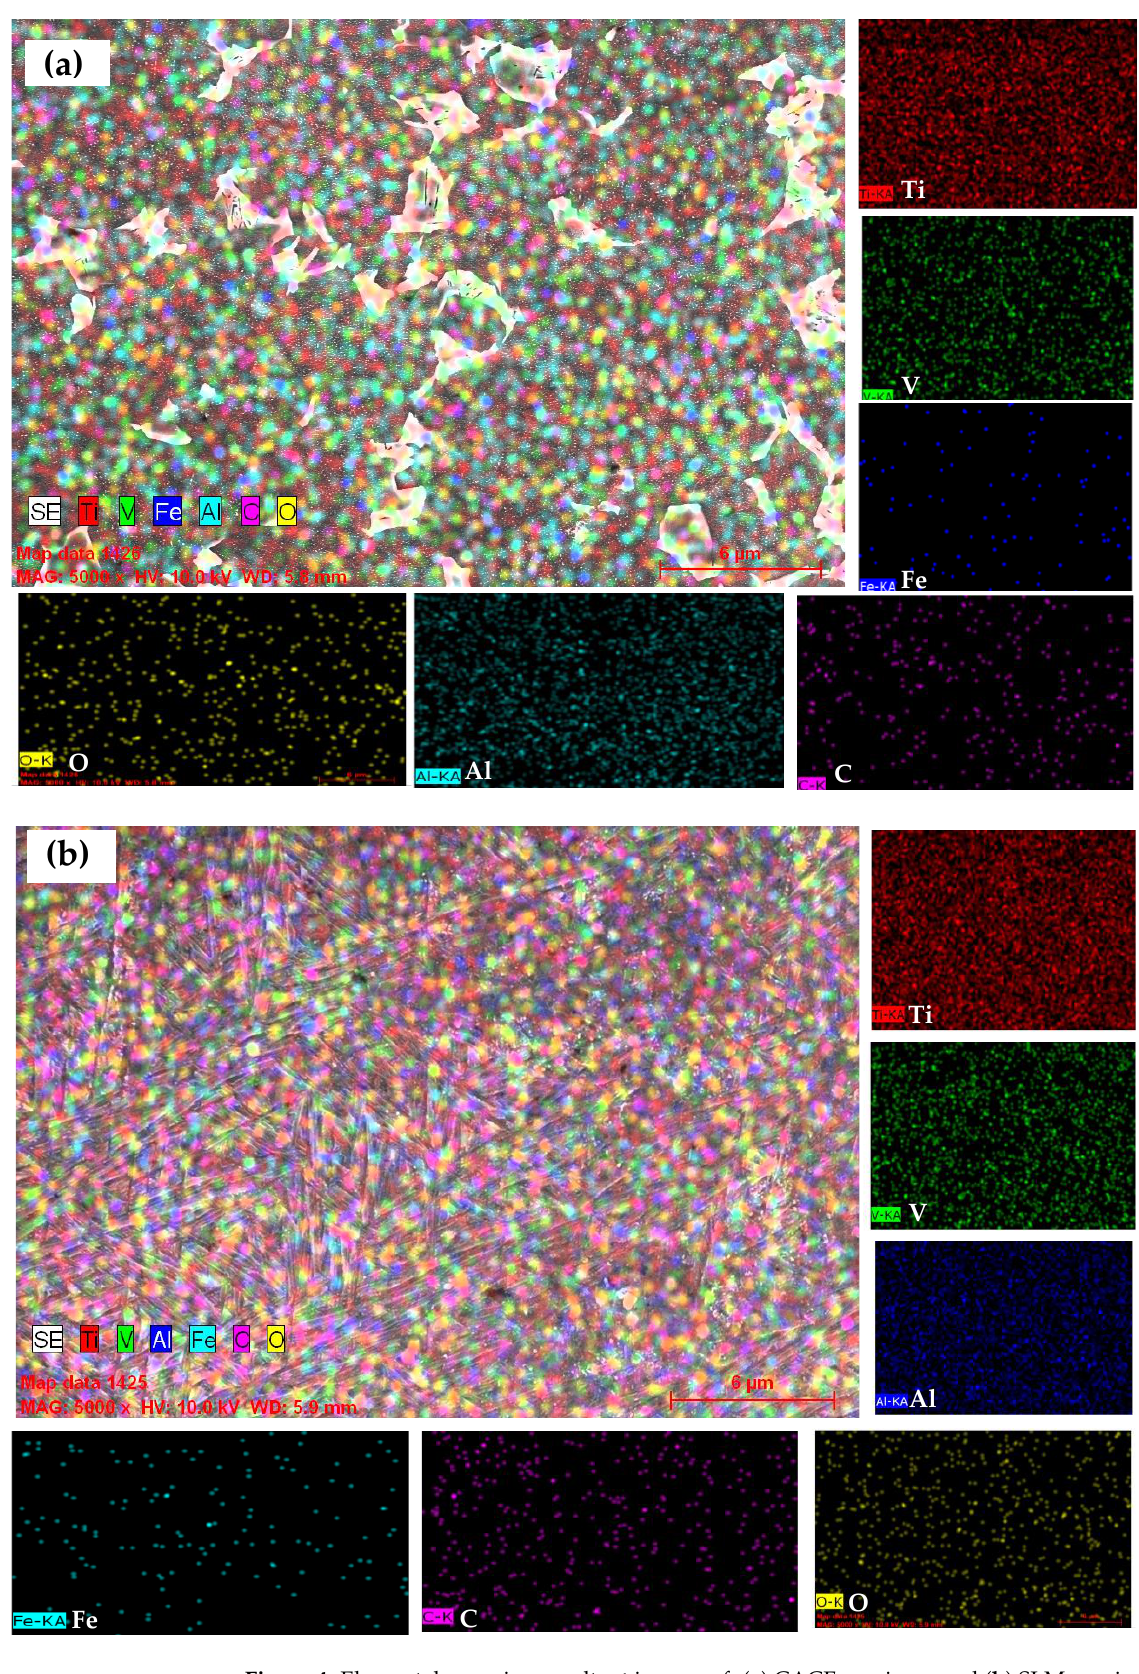
Figure 4. Elemental mapping resultant images of: ( a ) CACF specimen and ( b ) SLM specimen.